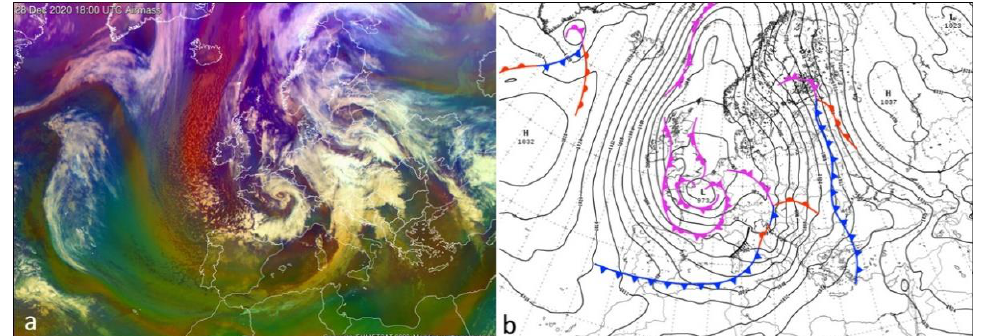
Figure 7. ( a ) Satellite image (EUMETSAT 2020) and ( b ) sea level barometric map (CFS Reanalysis) relative to 28 December 2020-H18:00 UTC. The intense cyclonic system over France is characterized by a complex system of occluded fronts (magenta lines). Blue lines are cold fronts, and red lines are warm fronts.